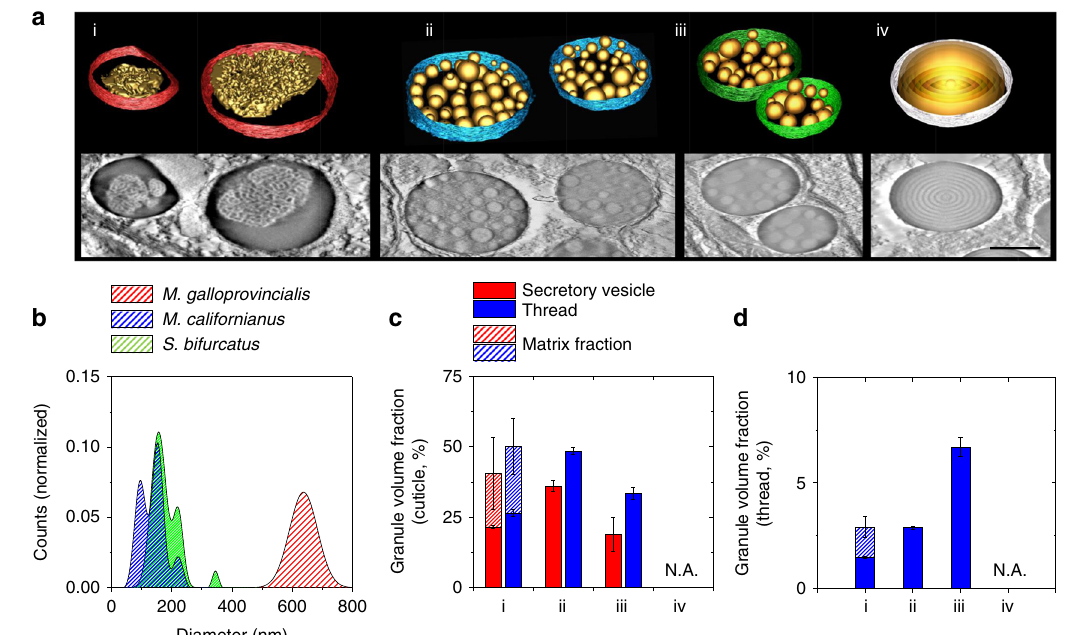
Fig. 5 3D structural features and volume fractions. All panels labeled with (i) represent M. galloprovincialis , (ii) M. californianus , (iii) S. bifurcatus , and (iv) M. capax . a Reconstructed tomographic representations of the secretory vesicles and encapsulated structures (scale bar = 500 nm); b fi tted size distributions of M. galloprovincialis (red, n = 122), M. californianus (blue, n = 176), and S. bifurcatus (green, n = 102) as deduced from TEM and electron tomographic investigations. c Granular volume fractions from the secretory vesicles (blue) compared to those of the cuticle (green, see Supplementary Figure 7 for full datasets), as well as normalized to the total thread size ( d ), show an increase in granular density after thread formation. Note that the intergranular matrix space in M. galloprovincialis is taken into account as well (dazzled segments, n = four tomographic sections, technical replicates, 1 µ m × 1 µ m × 60 Z slices, mean ±